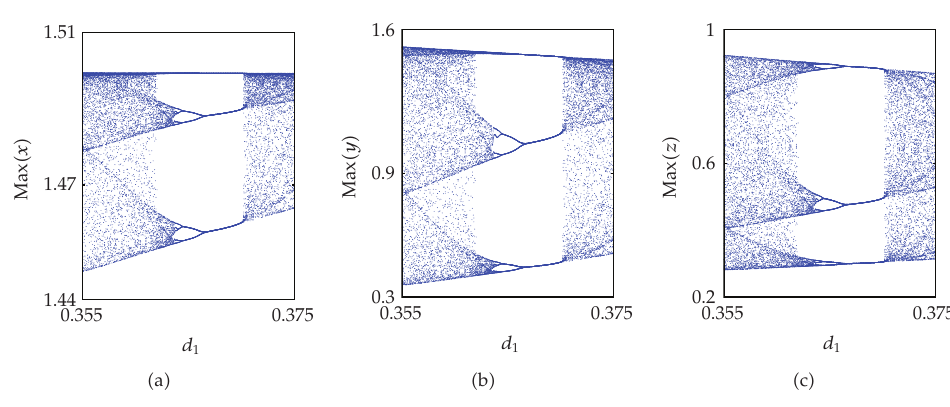
Figure 5: Magnification of Figure 4 when 0 . 355 < d 1 < 0 . 375.